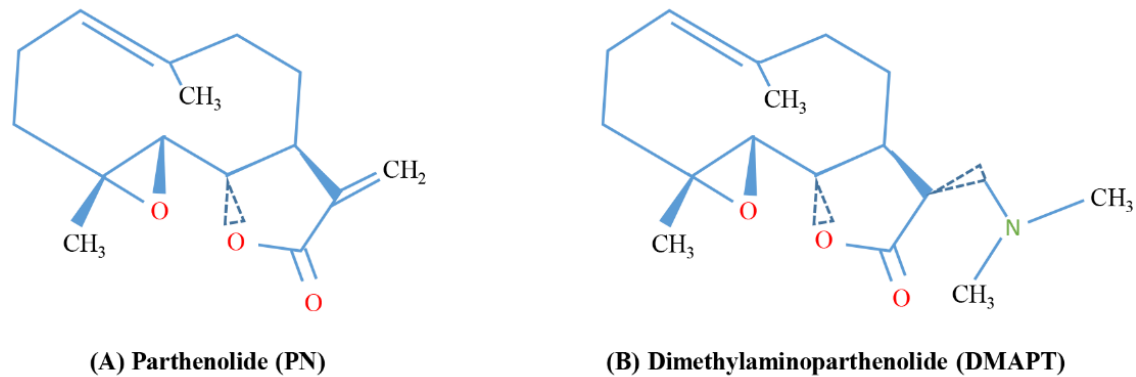
Figure 1. Chemical structures of ( A ) parthenolide (PN) and its analogue ( B ) dimethylaminoparthenolide (DMAPT).